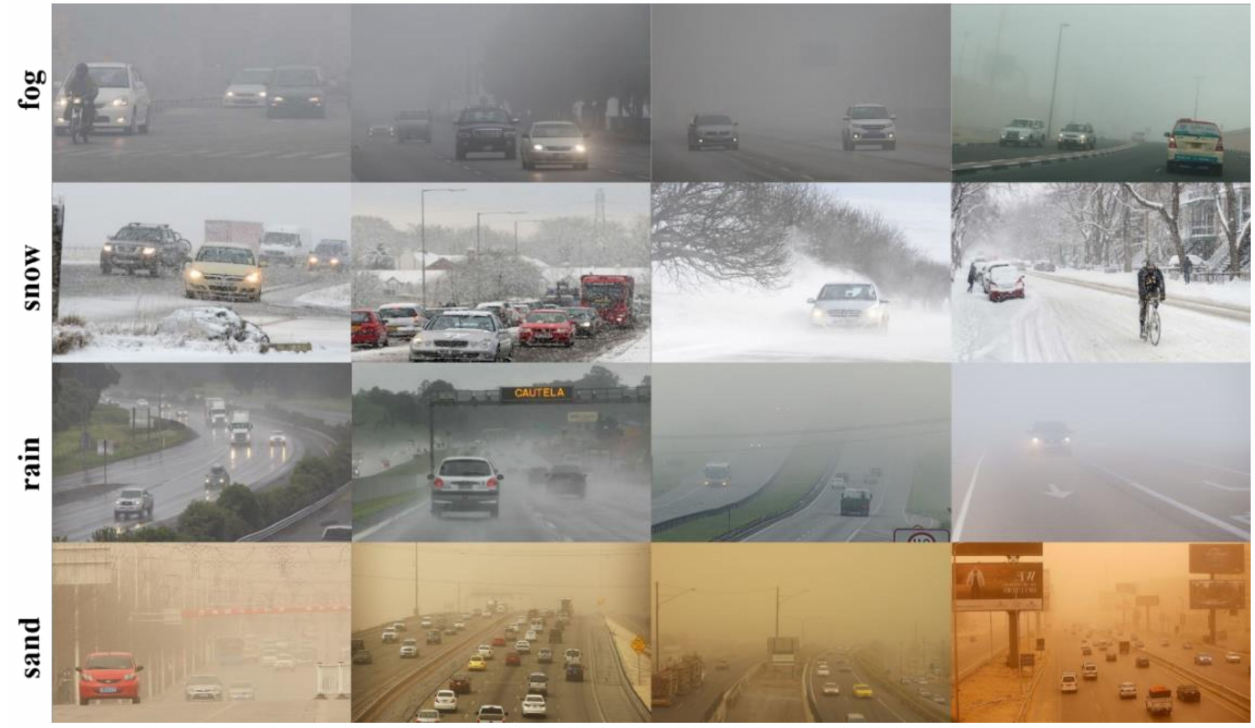
Figure 1. Schematic diagram of the adverse weather